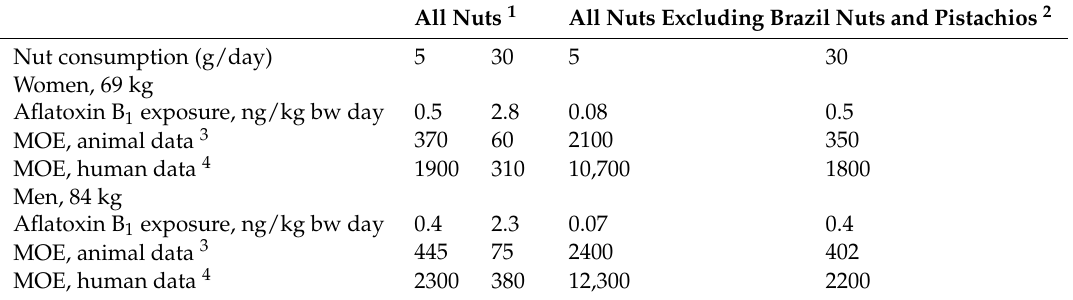
Table 3. Aflatoxin B 1 exposure and margin of exposure (MOE) by sex and level of nut consumption. All Nuts 1 All Nuts Excluding Brazil Nuts and Pistachios